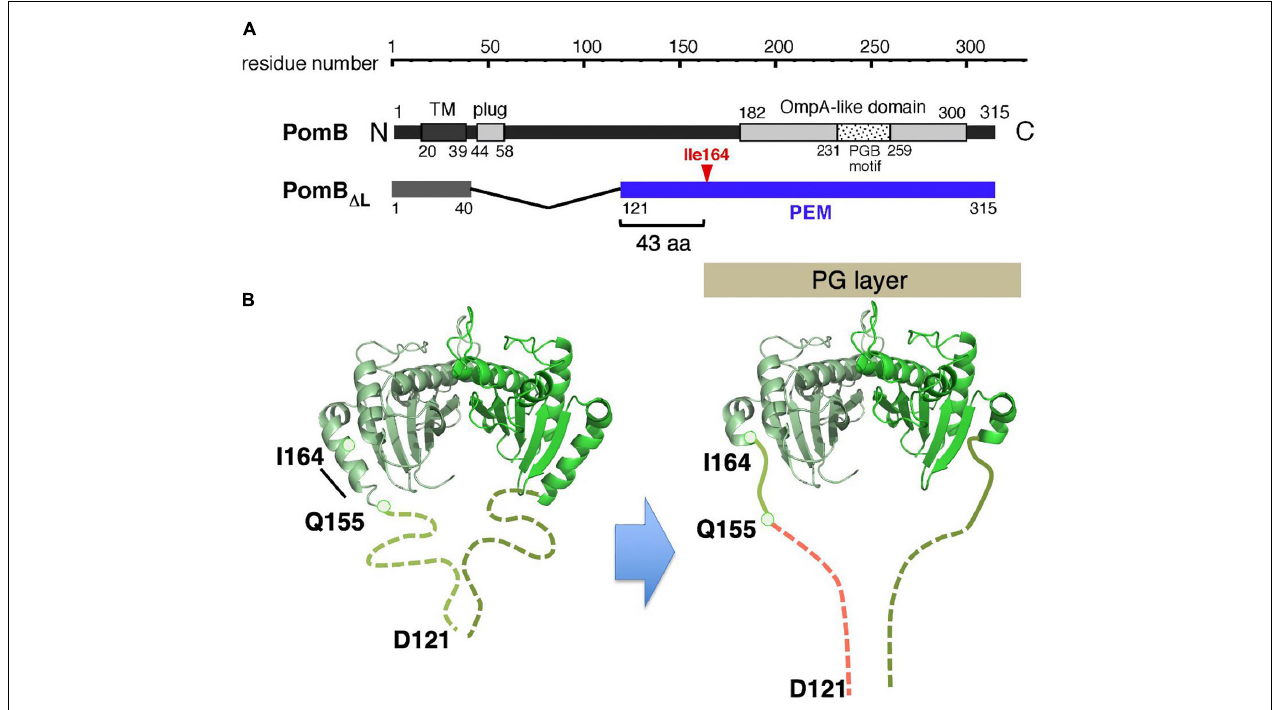
FIGURE 6 | (A) Primary structure of Vibrio alginolyticus PomB. The PEM for MotB is shown by the blue line in the in-frame deletion mutant (PomB (cid:49) L ). (B) A model of the conformational change in PomB coupled to the stator assembly. The periplasmic fragments (PomB C ) of Vibrio PomB (PDB: 3WPW) shown by the ribbon diagram are connected with a linker (dotted lines) (left). The N-terminal two-thirds of helix α 1 change conformation to an extended form that is able to anchor to the PG layer